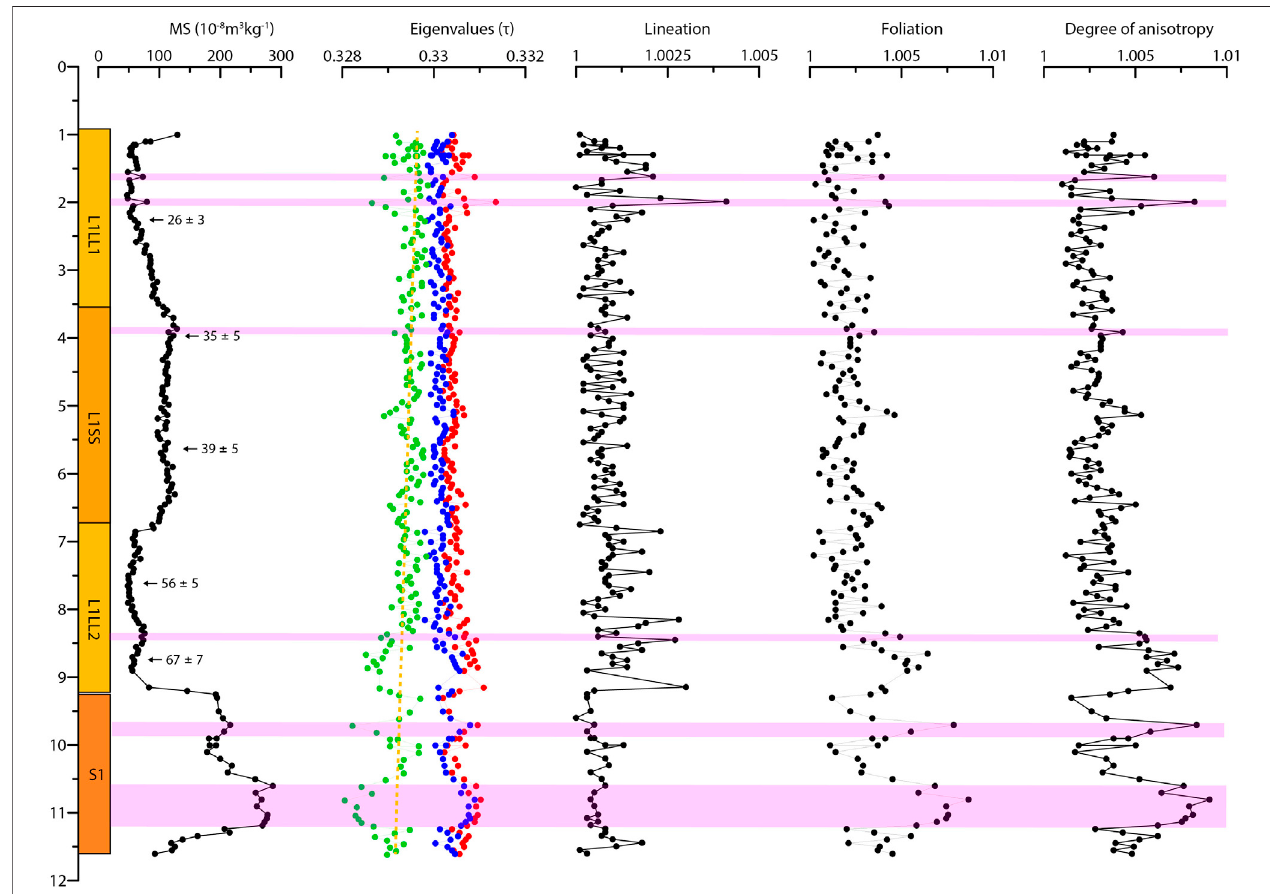
FIGURE 6 | The depth vs. variation of magnetic susceptibility, eigenvalues of three principal anisotropy of magnetic susceptibility axes ( τ max in red, τ int in blue, and τ min in green), lineation (L), foliation (F), and degree of anisotropy (P) in the Luochuan section. TL ages are from Porter and An (1995). Pink bars showing some extreme cases with high P and F, related to high MS values and τ -max, and low τ -imin.